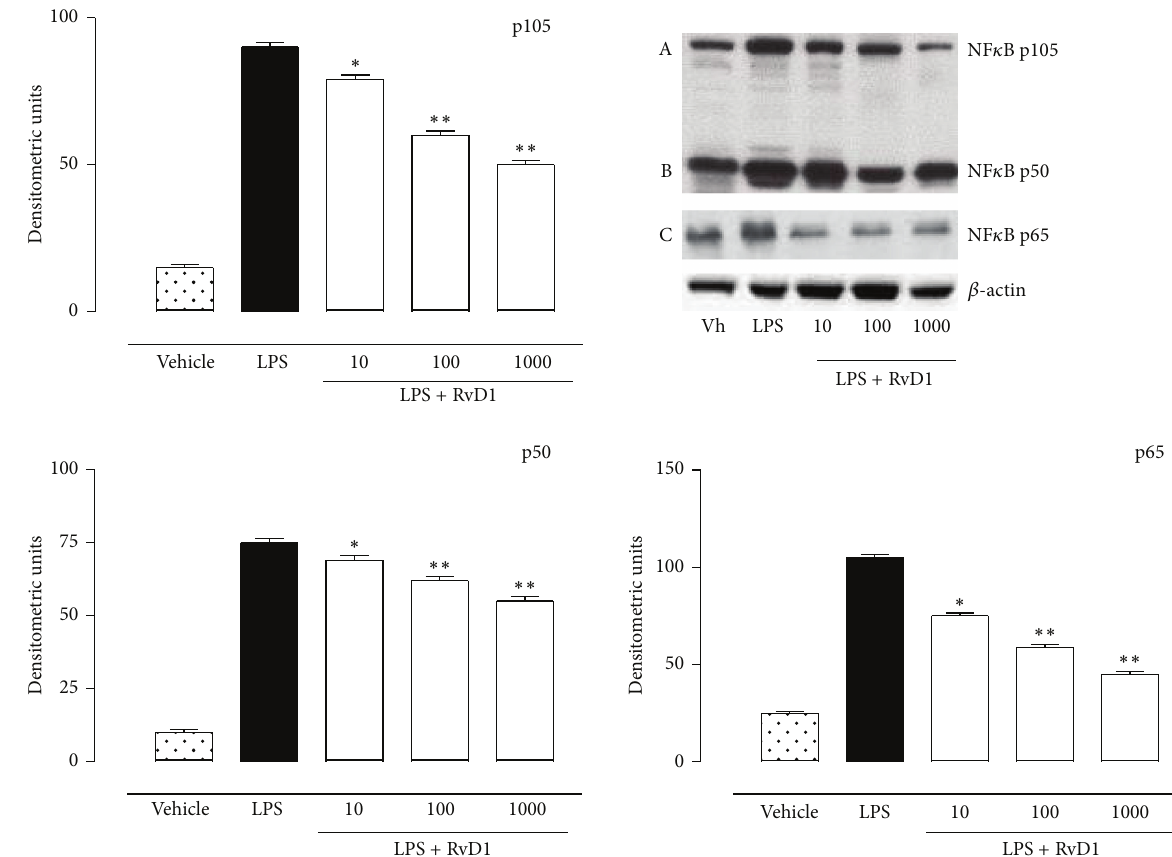
Figure 6: Western blotting analysis for NF- 𝜅 B. Western blotting technique showed that injection of resolvin D1 (RvD1, 10-100-1000ng/kg) into the vitreous of LPS-treated rats reduced the expression of activated NF- 𝜅 B: p50, p65, and p105. Results are expressed as densitometric units and represented the mean ± SEM of 𝑛 = 6 observation for each group. Vh = vehicle; ∗ 𝑃 < 0.05 and ∗∗ 𝑃 < 0.01 versus LPS-treated